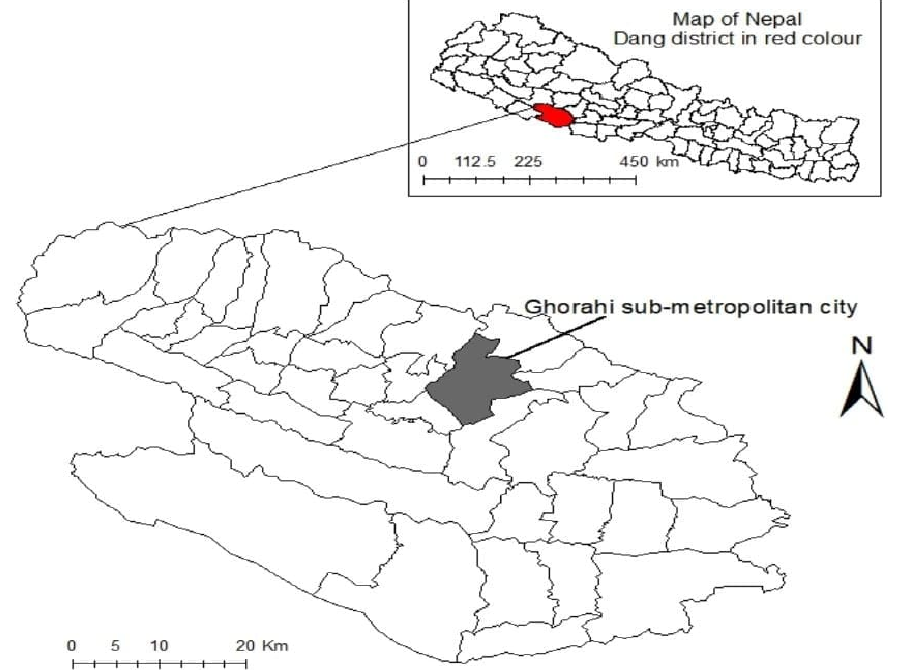
Figure 1. Map of the Study Area.